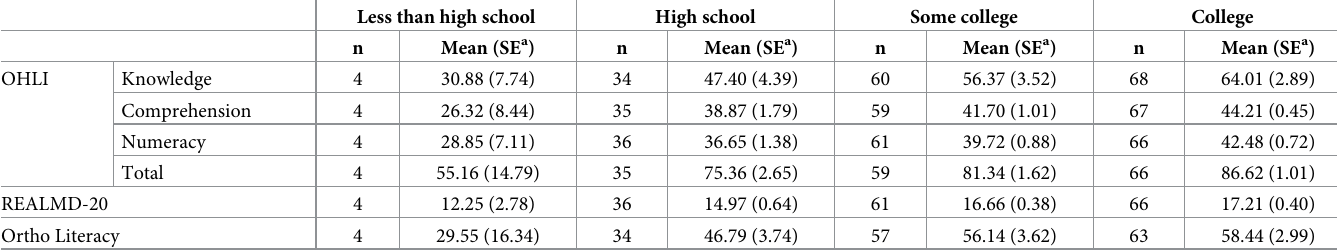
Table 5. Oral health and orthodontic literacy scales by education level.